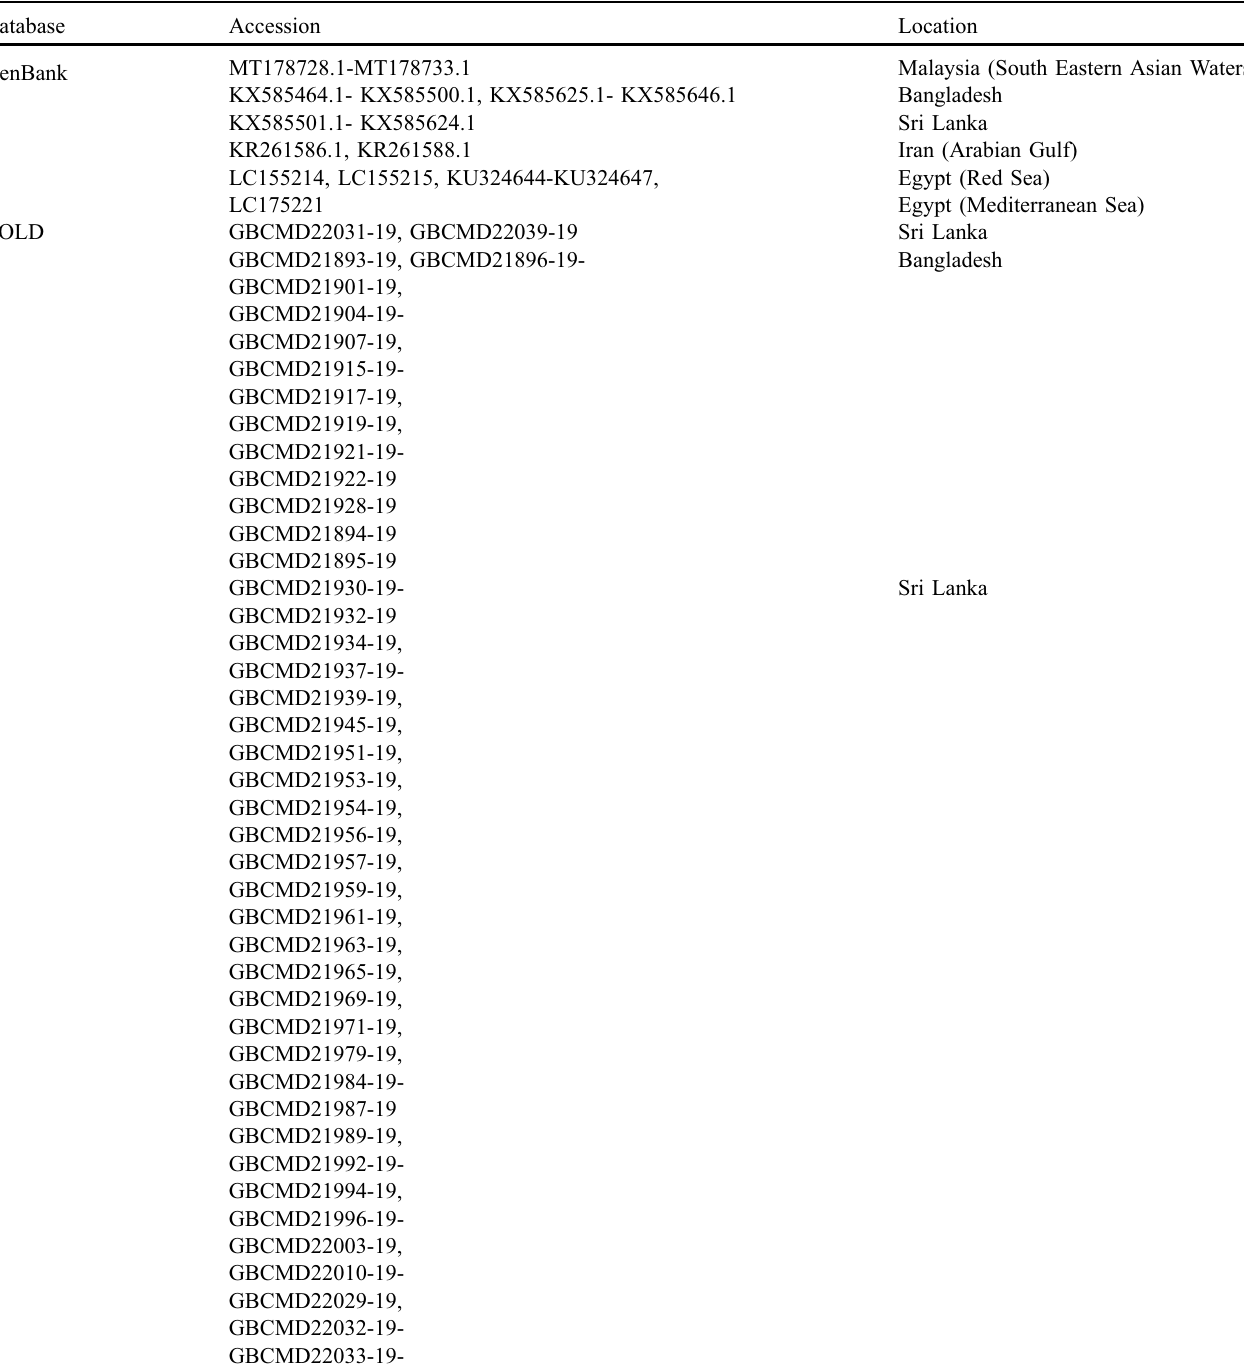
Table 1. Accession numbers and locations for GenBank and BOLD-retrieved COI sequences of P. semisulcatus from different areas of the world